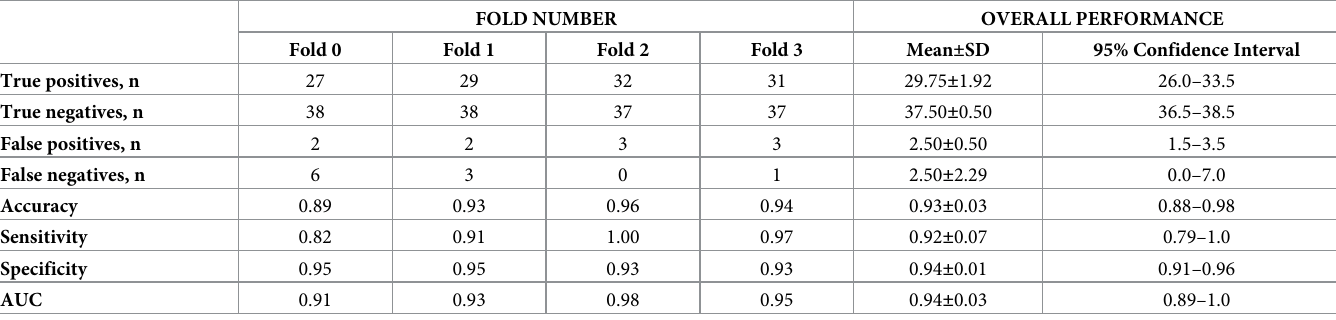
Table 2. 4-fold cross validation results a